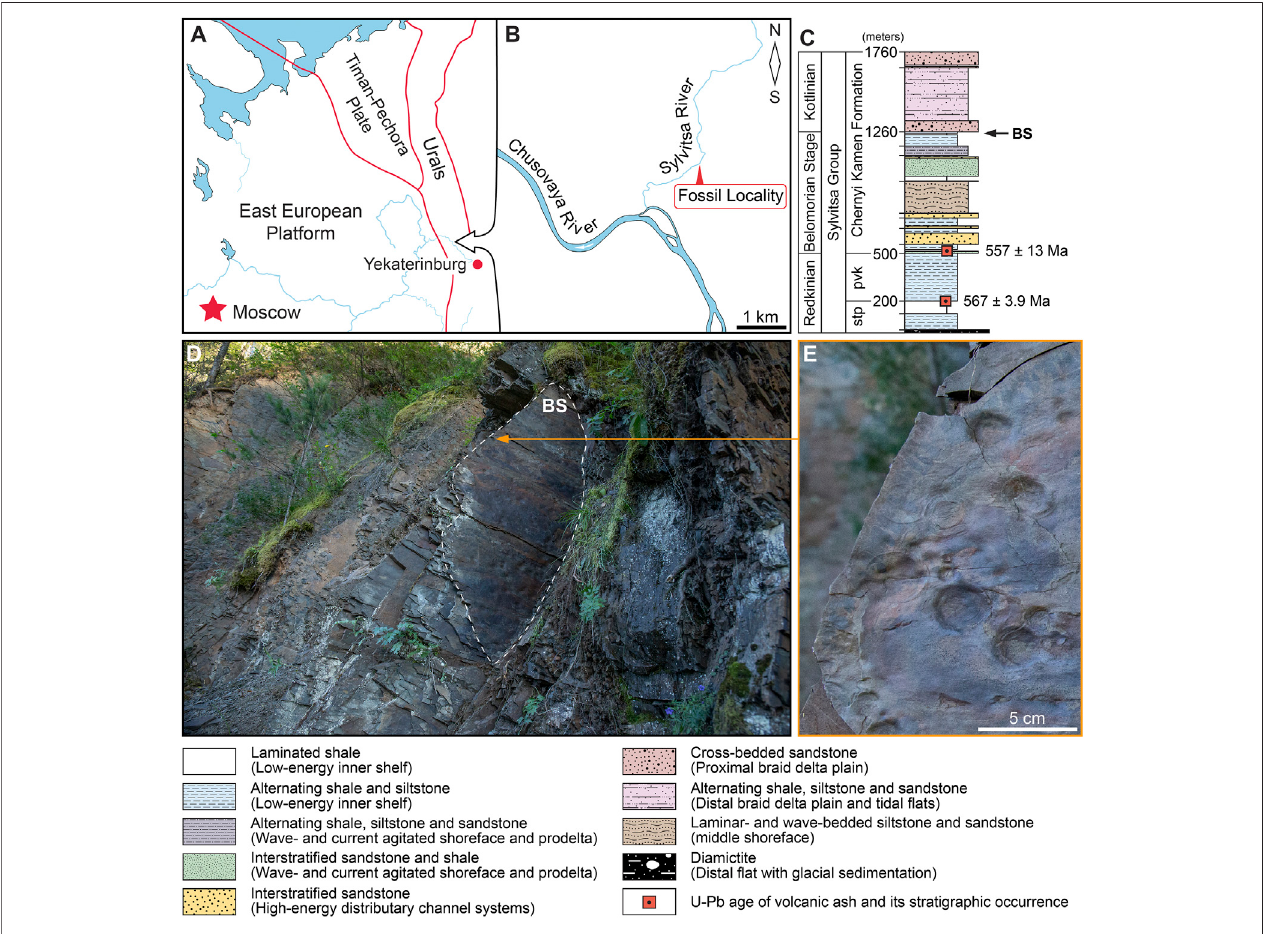
FIGURE1| Fossillocalitymapandstratigraphiccolumn: (A) CentralUralsanditspositionontheEastEuropeanPlatform; (B) studiedoutcropoftheChernyiKamen Formation, lower reach of the Sylvitsa River, (Sverdlovsk region of Russia); (C) Sylvitsa Group section showing the position of the BS surface with Beltanelliformis konovalovi sp. nov. fossils; (D) fi eld photograph of the BS surface brushed in the Konovalovka Member; (E) close-up fi eld photograph of B. konovalovi sp. nov.